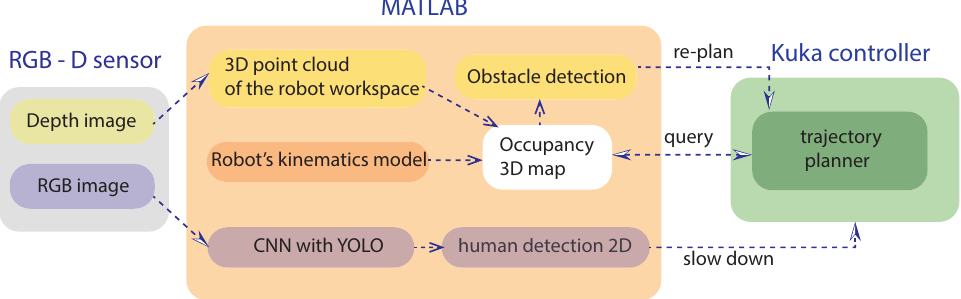
Figure 5. Architecture setup for obstacle detection at different working range. Data stream, processing and communication between sensor node and robot controller are